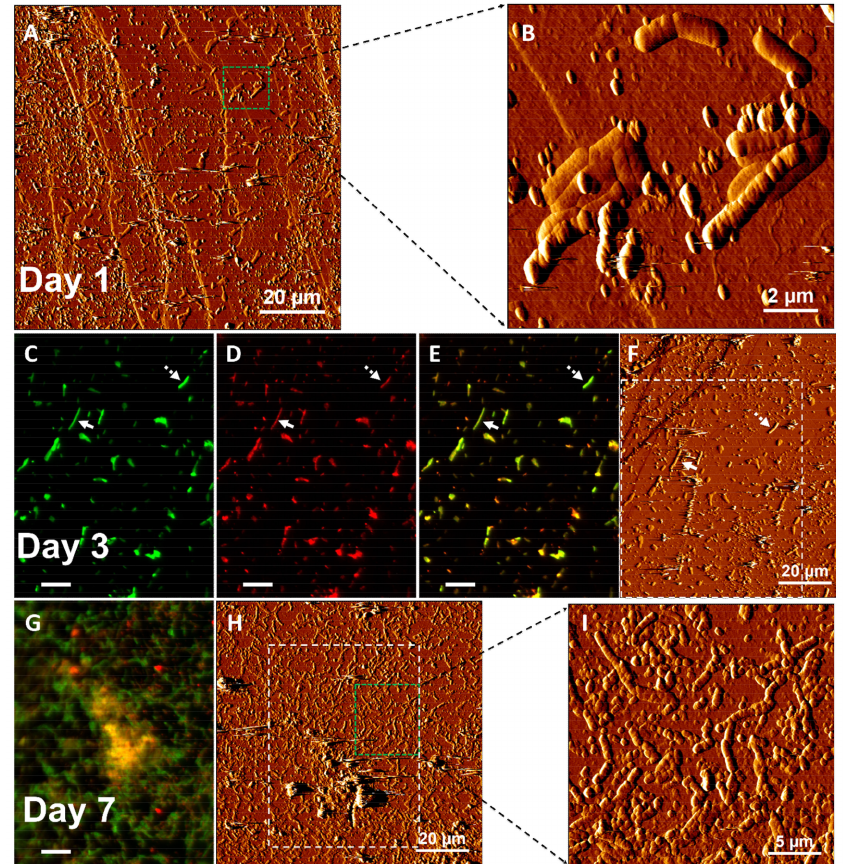
Figure 2. Surface colonization and partial biofilm formation by cells of At. ferrooxidans 61 on a pyrite coupon after 1 day ( A , B ), 3 days ( C – F ) and 7 days ( G – I ) of incubation at 30 ◦ C and shaking at 130 rpm in the dark. AFM images ( A , B , F , H , I ), EFM images ( C – E , G ). EFM images: ( C ) biofilm cells stained by Syto ® 9 (Green). ( D ) biofilm cells stained with Tetramethylrhodamine (TRITC)-Con A (Red). ( E , G ) combination of Syto ® 9 and TRITC-Con A. The framed area in ( F ) corresponds to the same area in ( C – E ) observed by EFM. The framed area in ( H ) corresponds to the same area in ( G ) observed by EFM. The framed areas by green lines in ( A ) and ( H ) are zoomed in (B) and (I) respectively. Bars in ( C – E , G ) represent 10 µ m. Dashed and solid arrows in ( C – F ) point at the same bacterium,